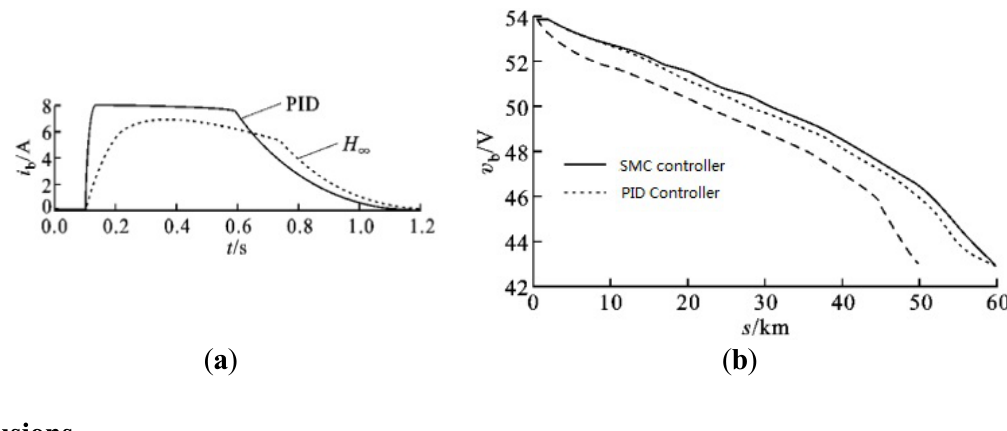
Figure 11. Waveform of the driving range in regenerative braking control of EVs using proportion-integral-derivative (PID) controller and sliding mode controller (SMC), respectively. ( a ) Braking current using PI/SMC controller; and ( b ) driving range using different